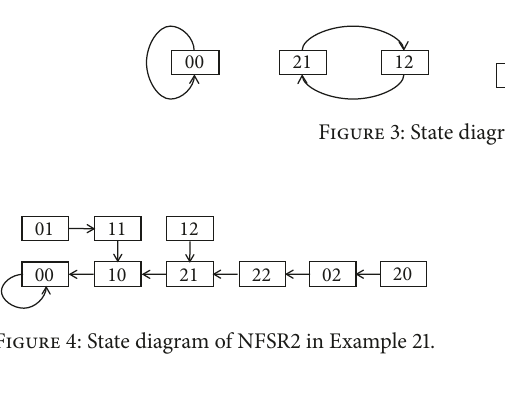
Figure 4: State diagram of NFSR2 in Example